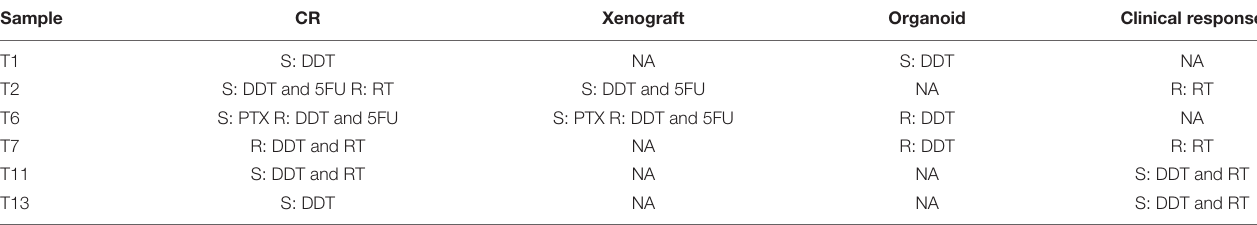
TABLE 5 | Overview of therapy responses of six representative tumors and corresponding in vitro models. Sample CR Xenograft Organoid Clinical